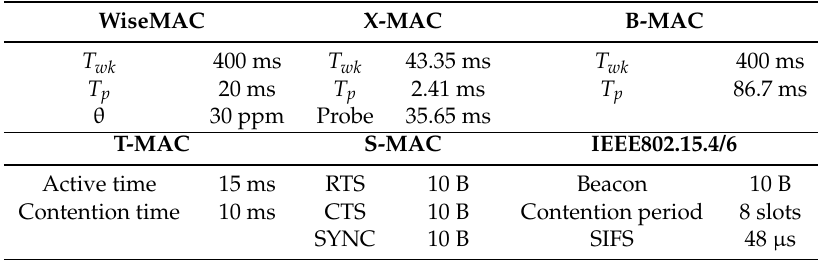
Table 5. MAC-specific input parameters. RTS, request to send; CTS, clear to